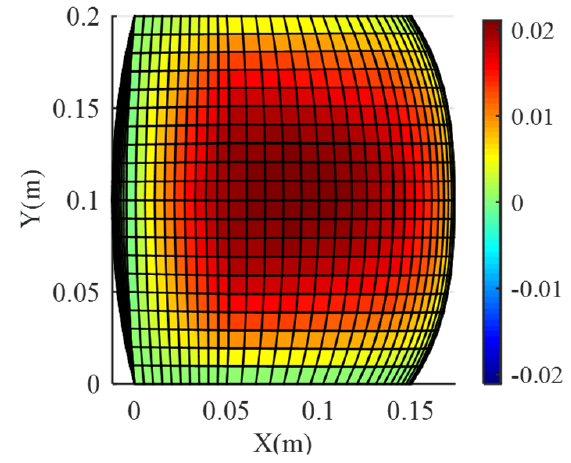
Figure 13. Z-axis displacement of single finger chamber.